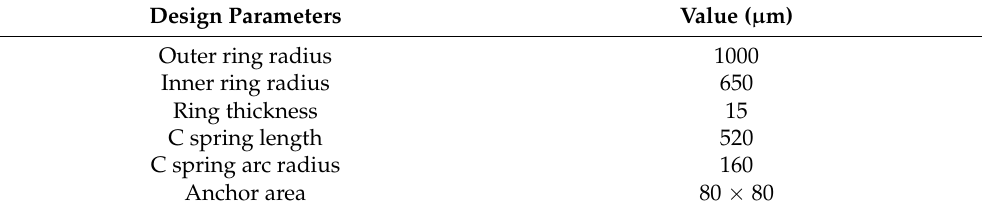
Table 1. Design features of starfish-shaped MEMS vibratory ring gyroscope.